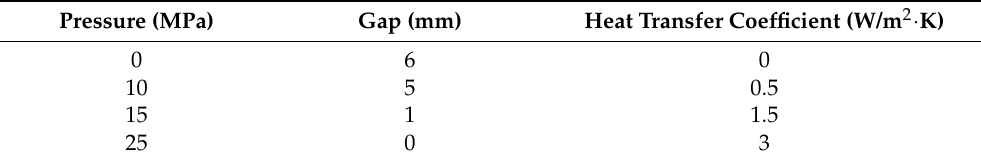
Table 3. Heat transfer coefficients in FE